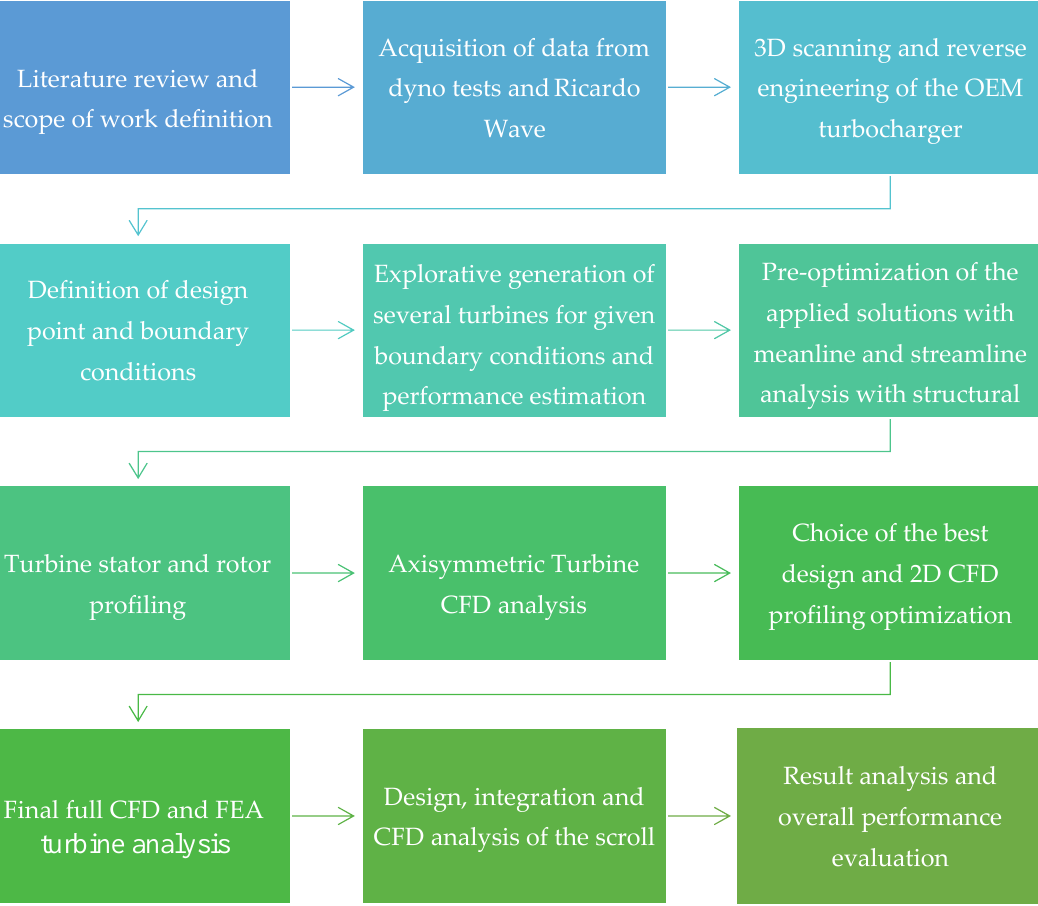
Figure 1. Methodology flow chart. CFD: Computational Fluid Dynamics; Finite Element Analysis (FEA); OEM: Original Equipment Manufacturer.